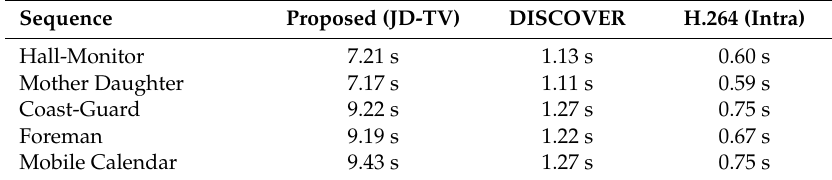
Table 10. Average decoding (execution) time (sec) comparison of proposed CS based JD-TV codec with conventional video codecs (DISCOVER, H.264 (intra)) for various video sequences.